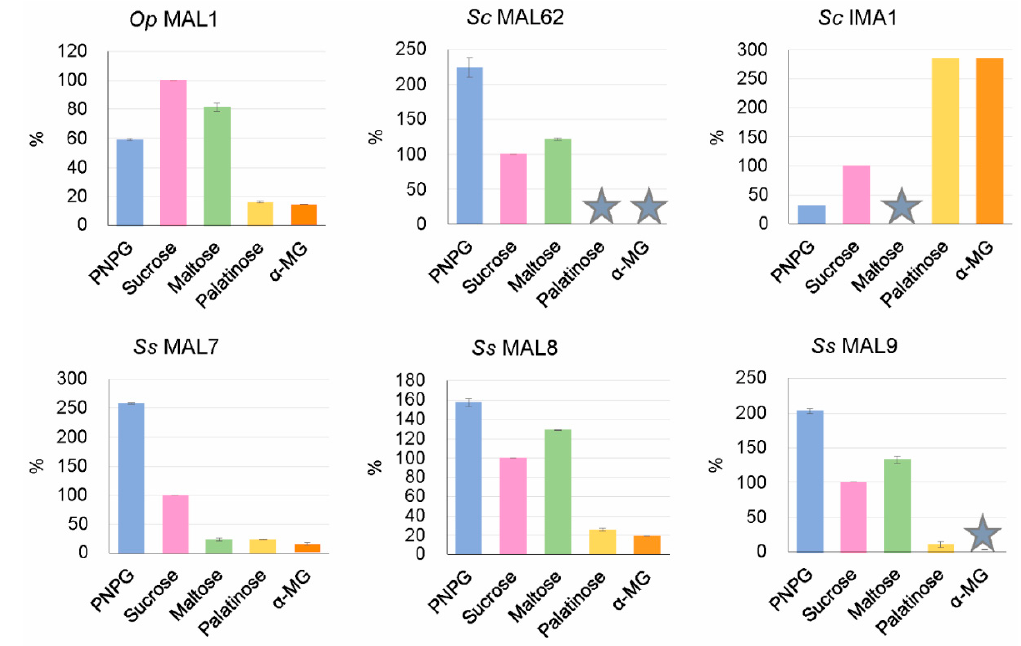
Figure 4. Substrate specificity of S. stipitis MAL7, MAL8, and MAL9 (lower panels) with O. polymorpha MAL1 (maltase-isomaltase), S. cerevisiae MAL62 (maltase), and IMA1 (isomaltase) (upper panels) used as references. Specific activity (µmol/mg · min) of each enzyme preparation with 100 mM sucrose was taken for 100%. Data on Sc IMA1 were calculated from Table 2 of [66], data on Op MAL1 were taken from Table 1 of [12]. The asterisk shows nondetectable or only negligible activity with corresponding substrates. Standard deviation values of the mean are given on the bars. See [66] for standard deviation data of Sc IMA1.